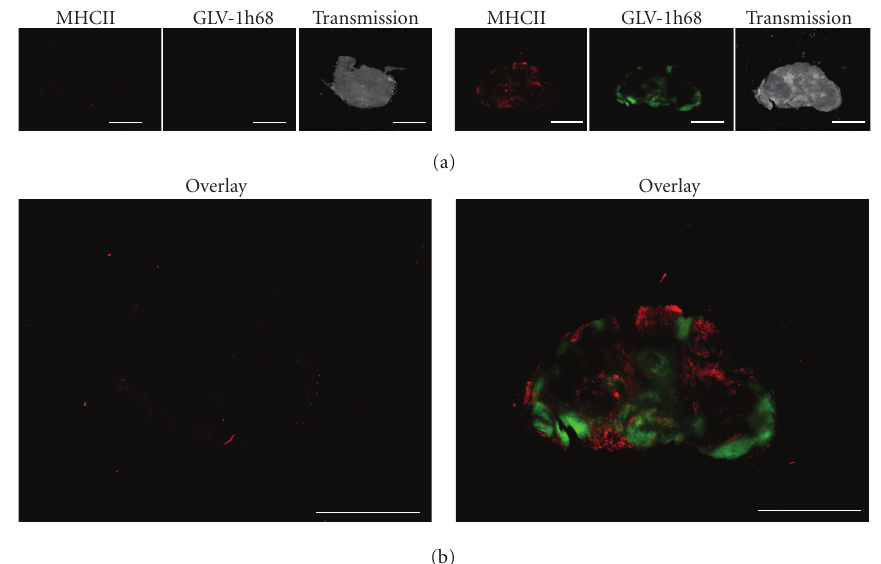
Figure 8: Immunohistochemistry staining of MHC class II positive cells in PC-3 tumors. (a) Forty-two days after GLV-1h68 administration PC-3 tumors were excised, sectioned, and labeled for MHCII. In addition, GFP signals from GLV-1h68-infected cells and transmission images are shown. (b) Overlay of MHCII and GFP signals in uninfected (left) and virus-infected PC-3 tumors (right). Scale bars =